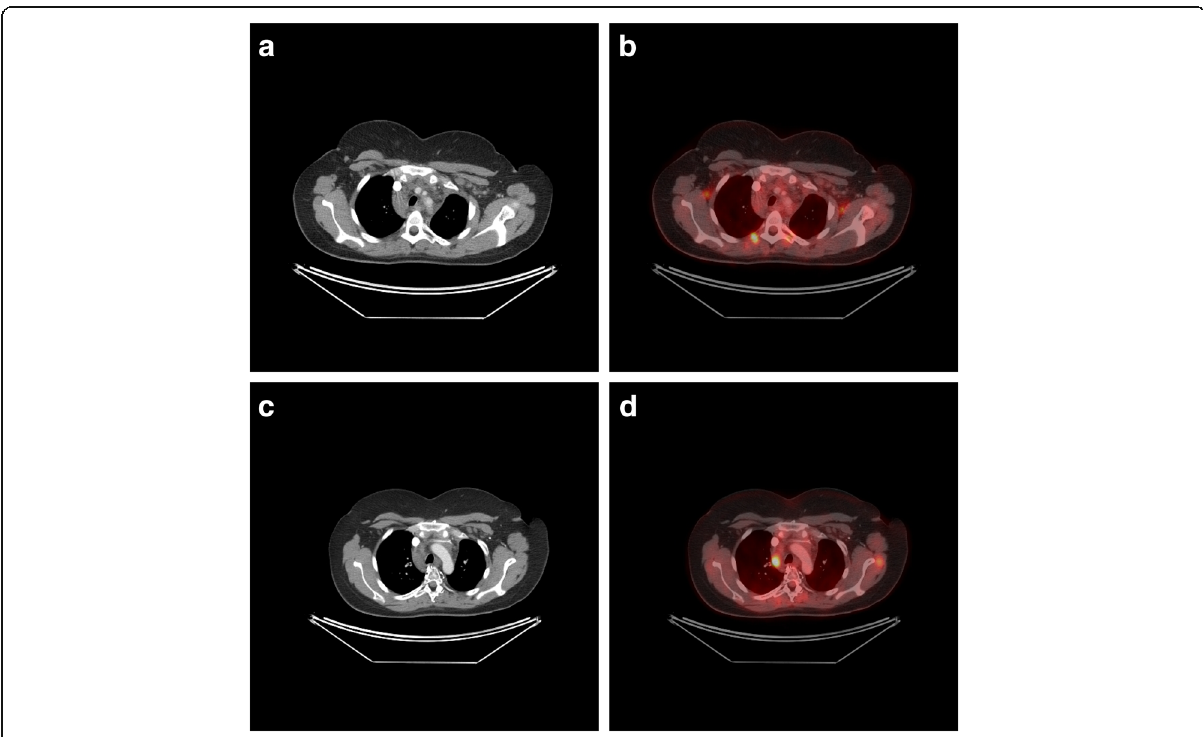
Fig. 4 A 34-year-old female patient known NHL. Interim PET-CT images ( a , b ) show subcentemetric non-metabolically active lymph node (arrows). PET CT images at end of therapy ( c , d ) showed no appreciable size change but with 18-FDG avid uptake. The patient was categorized as complete regression on CT and progressive on